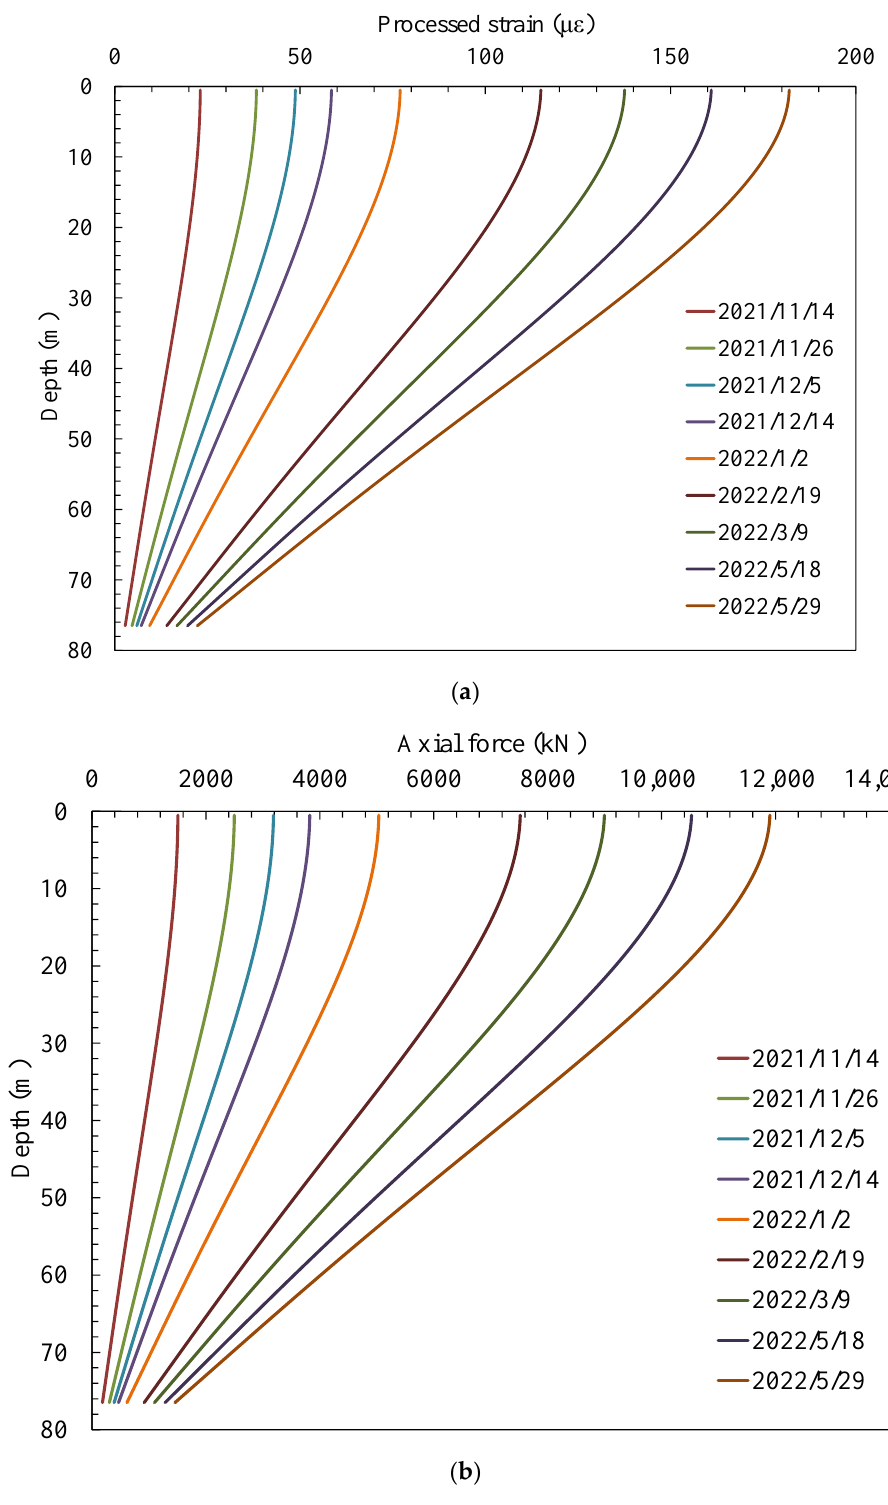
Figure 13. Processed axial strain and axial force along the pile: ( a ) processed axial strain; ( b ) axial force.